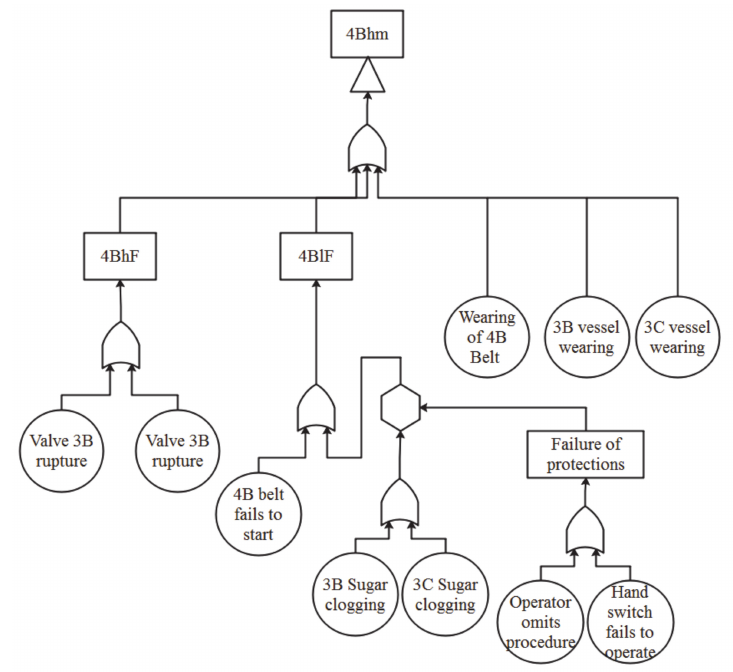
Figure 7. Transfer gate for the 4Bhm